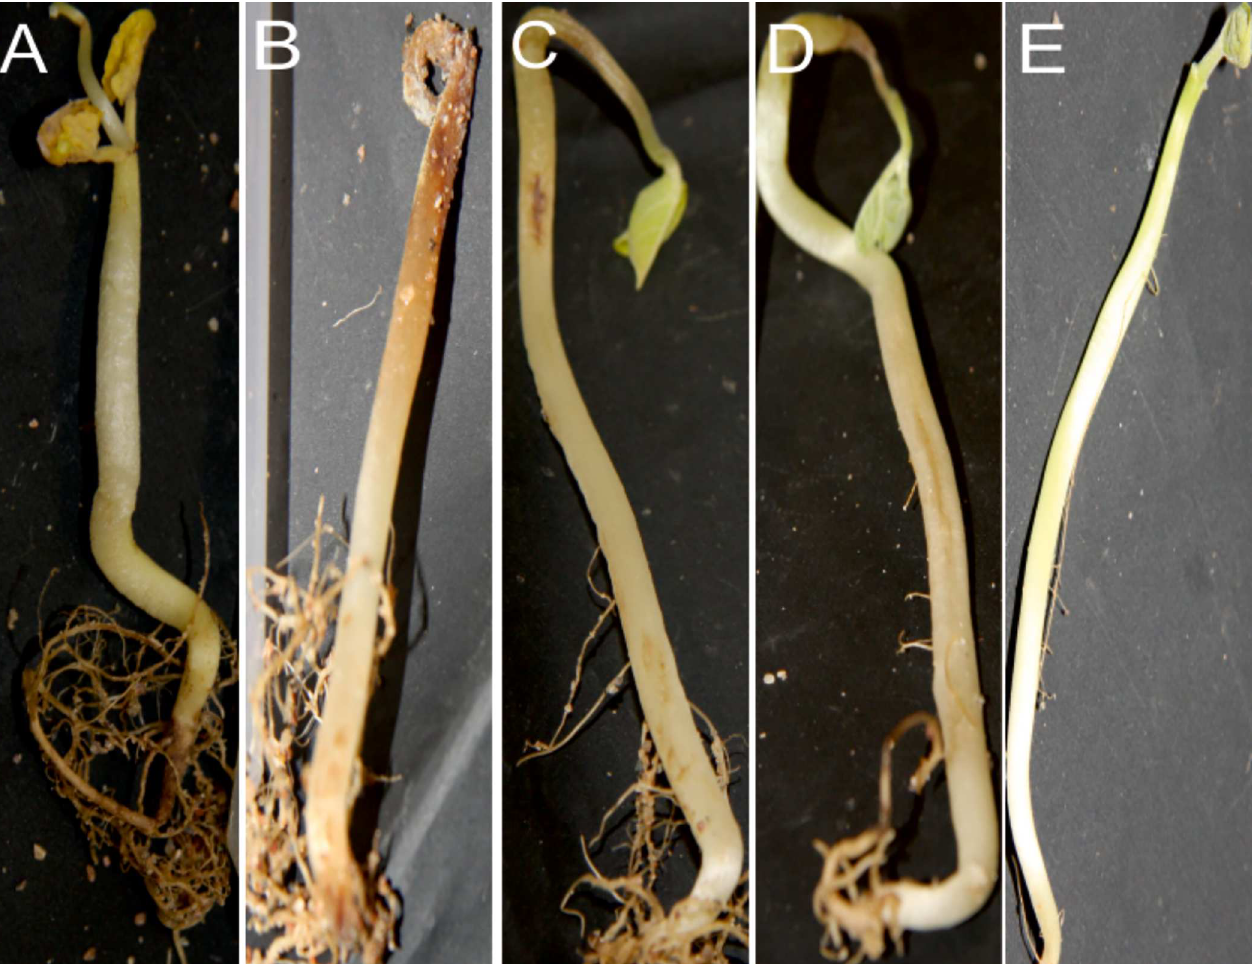
Fig 4. Symptoms of lima bean seedlings caused by fungal isolates of phenogroup VIII. (a) to (d), inoculatedplants at 20 dpi, and (e), non- inoculated control. (a) and (b), necrotic roots and whitish mycelia growingon the stem; necrosis at apex of the seedling.(c) and (d), cankers on stem and wilted apex of the